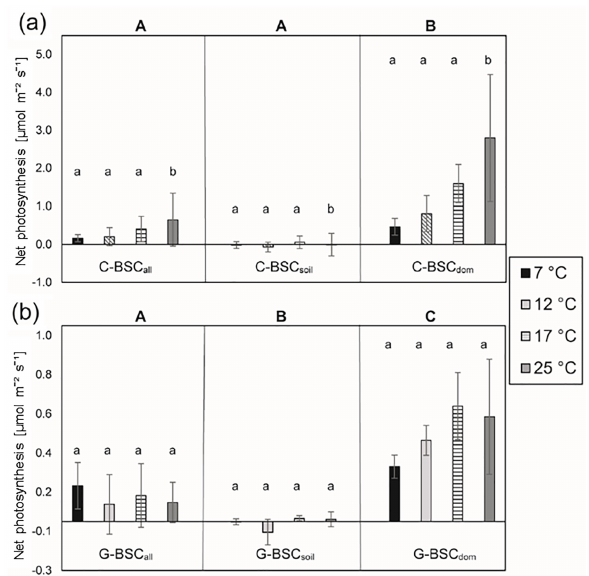
Figure 3. Temperature dependent net photosynthesis per area in (a) N. commune - and (b) Z. ericetorum -dominated BSCs, separated dominant organism and separate soil. Capital letters indicate signif- icant differences in organization level between BSC, organism and soil; lower case letters compare temperature differences of one of the organization groups only. Sample size was n = 6 for N. com- mune and n = 4 for Z. ericetorum .